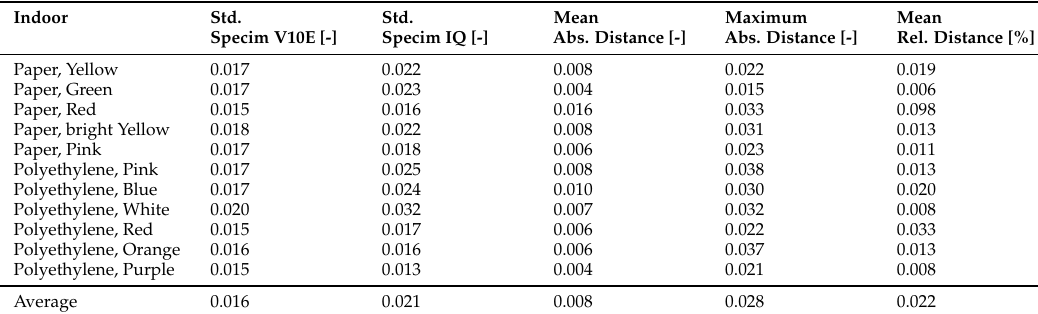
Table A1. Comparative performance parameters of the Specim IQ and Specim V10E observed in the laboratory under artificial light conditions. Mean standard deviation of the homogeneous color cards, the mean absolute distance between the mean spectra, the maximum absolute distance and the mean relative distance in percent.